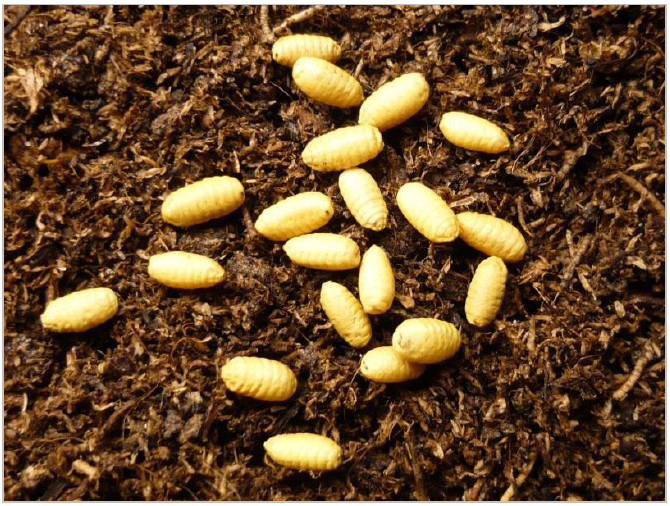
Figure 5. Pupae of R. cerasi